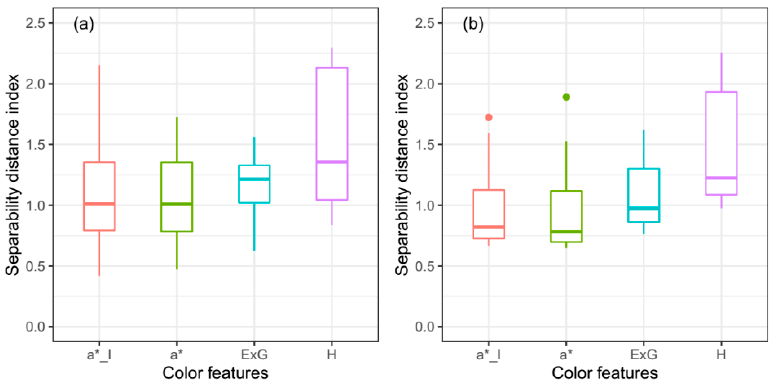
Figure 11. The distribution of separability distance index for a*_I, a*, ExG, and H: ( a ) is based on the Test_full data set; ( b ) is based on the Test_ws data